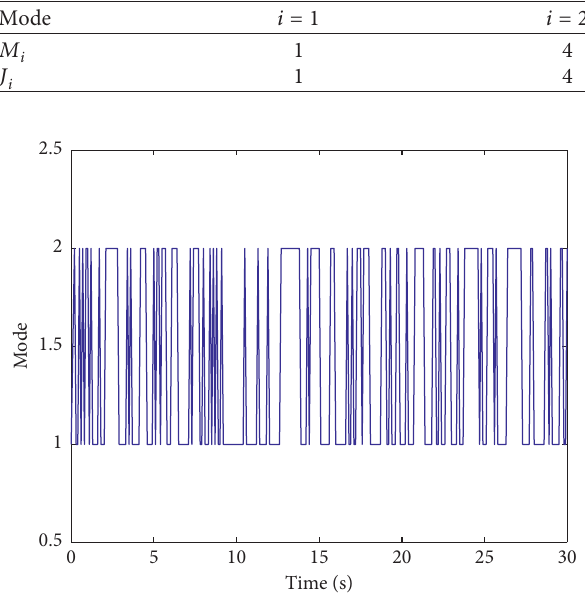
Figure 13: The Markov jump of Example